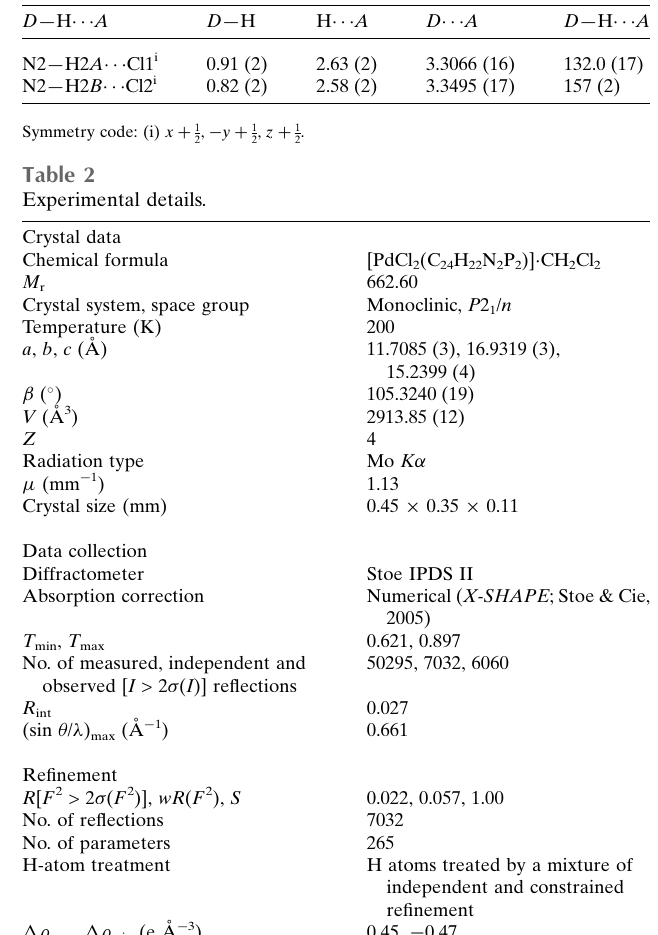
Table 1 Hydrogen-bond geometry (A˚ , (cid:3) ).